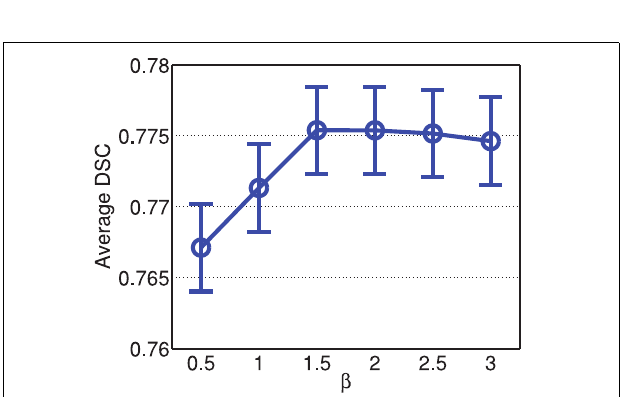
FIGURE 4 | Joint label fusion performance with respect to β (error bars at ± 0.05 standard deviation). Other parameters are set to r p = 2 , r s = 3 , α = 0 .